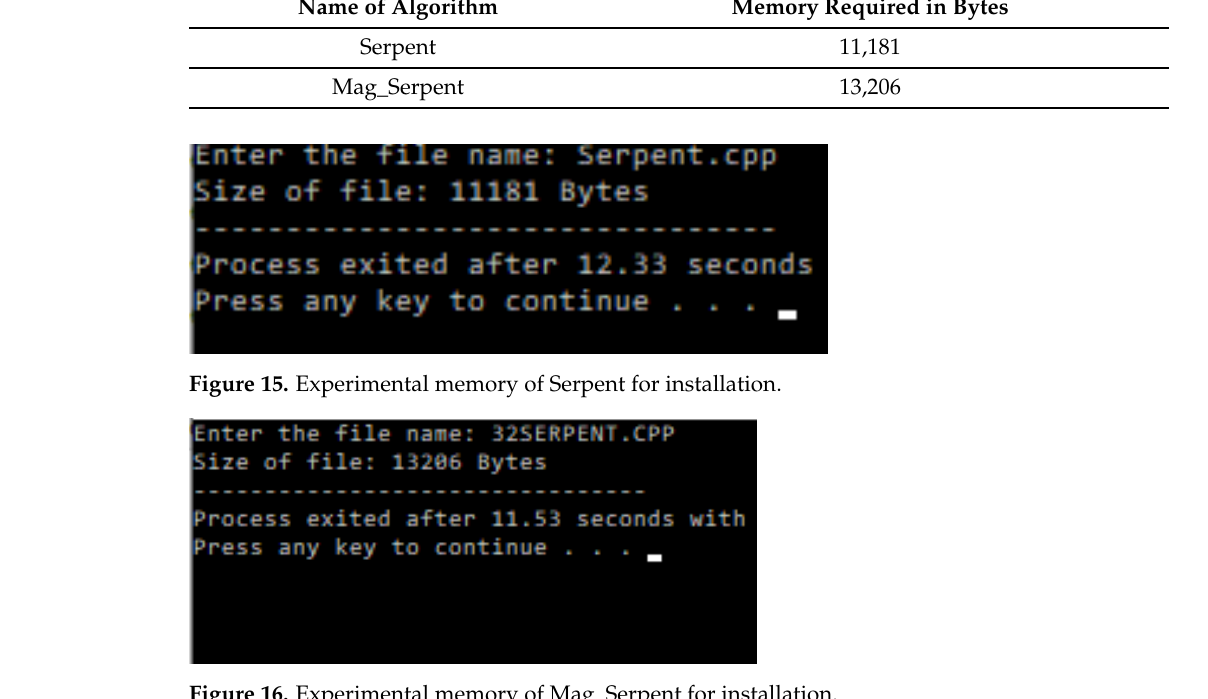
Figure 16. Experimental memory of Mag_Serpent for installation.